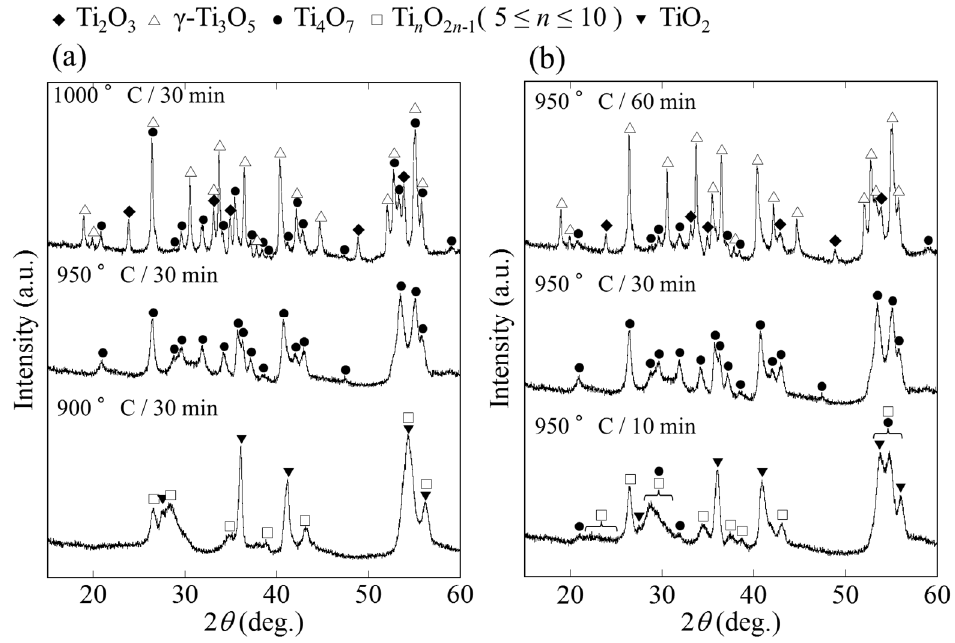
Figure 1. X-ray diffraction patterns of the samples synthesized by microwave irradiation at various heating temperatures ( a ) and times ( b ).